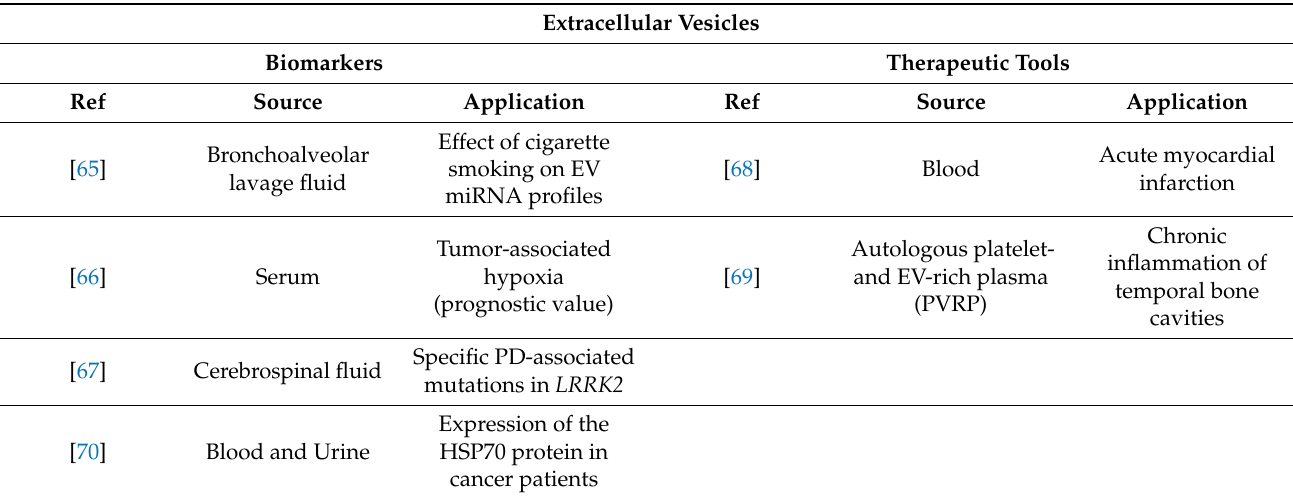
Table 1. Summary of clinical trials with “Extracellular Vesicles” as biomarkers or therapeutic tools.